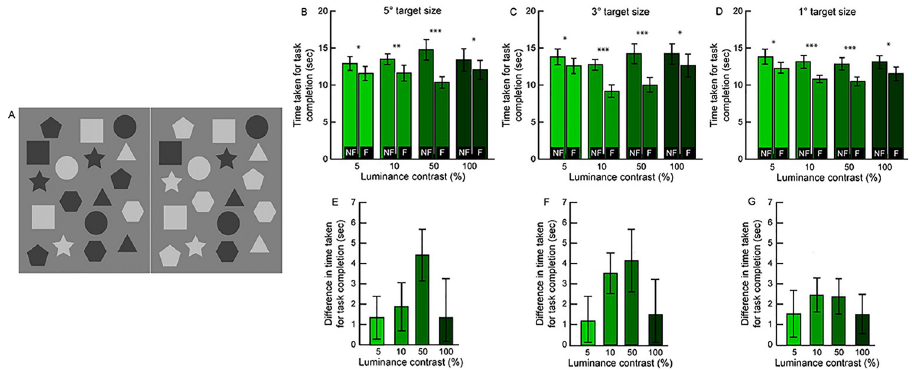
Fig 4. Sample grayscale image pair with 50% luminance contrast and 3˚ angular subtense used in Experiment 2 (Panel A). Mean ( ± 1 SEM) time taken for task completion across target contrasts and sizes in the non-fusion (NF) and fusion (F) modes of gameplay in Experiment 2 (panels B–D). Mean ( ± 1 SEM) difference in the time taken between the two modes of gameplay for each combination of target contrast and size (panels E–G). Asterisk symbols are same as Fig